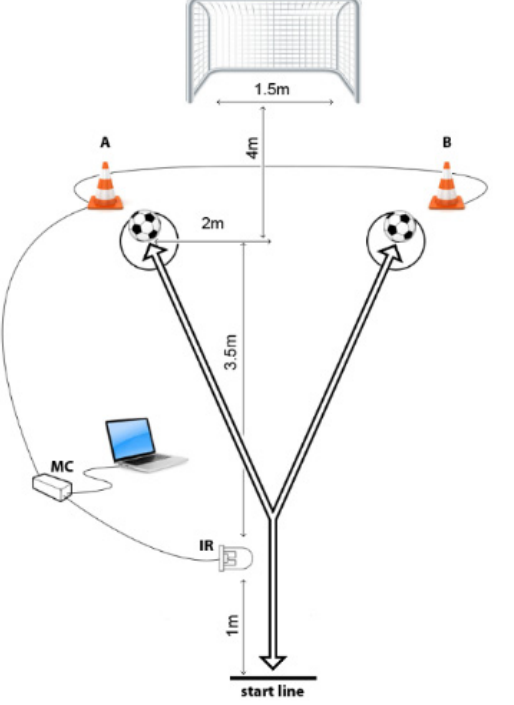
Figure 1. Soccer-specific change of direction speed and agility testing polygon.